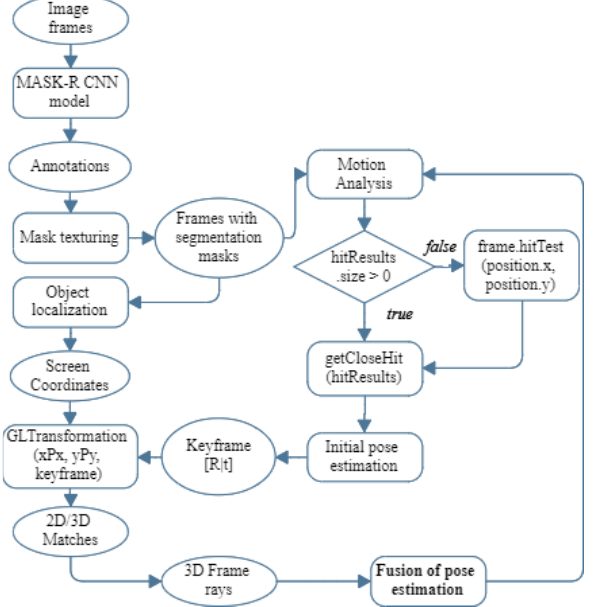
Figure 3: World coordinate frame ray computation for a screen point.